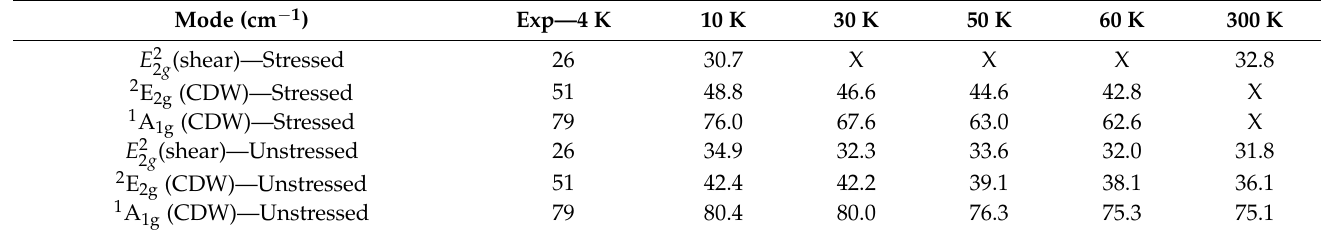
Table 1. A comparison of experimental and simulated Raman modes from References [99,109] for both the stressed and unstressed cases. The X indicates a missing value in the literature.